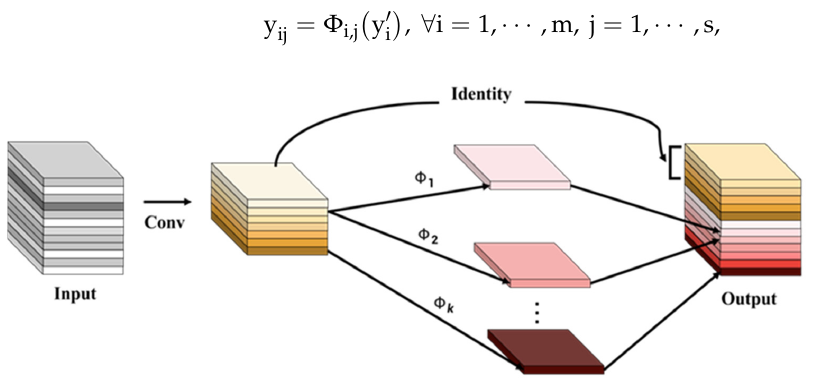
Figure 3. Ghost convolution schematic diagram.